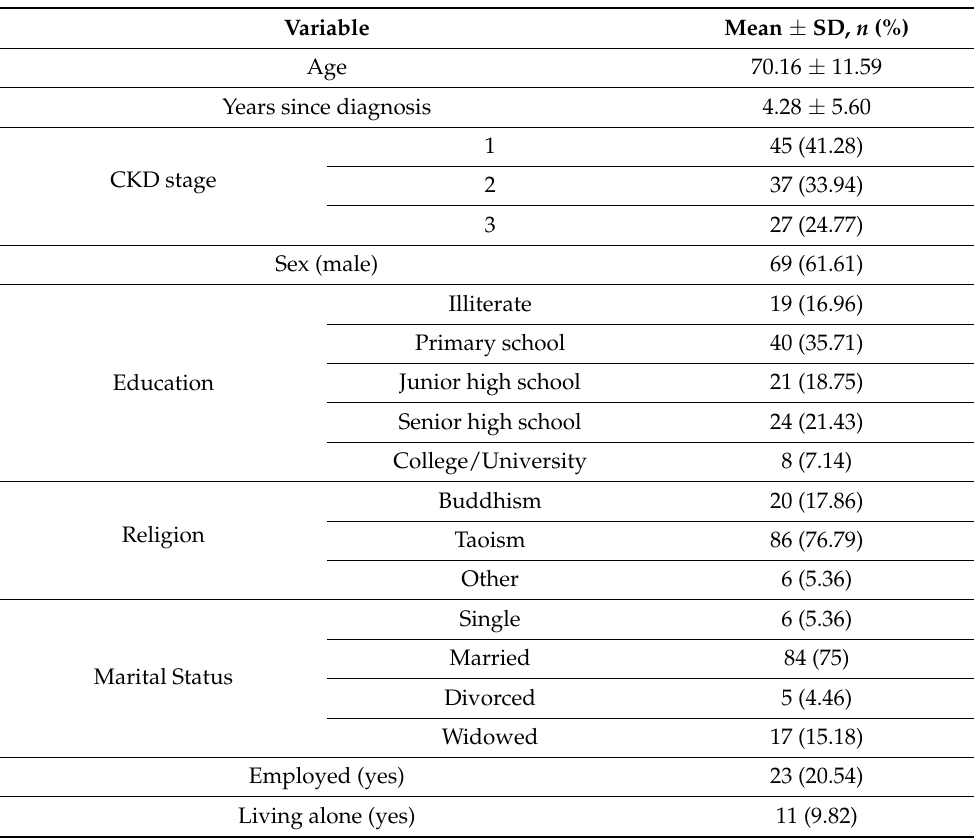
Table 2. Demographic characteristics of the study